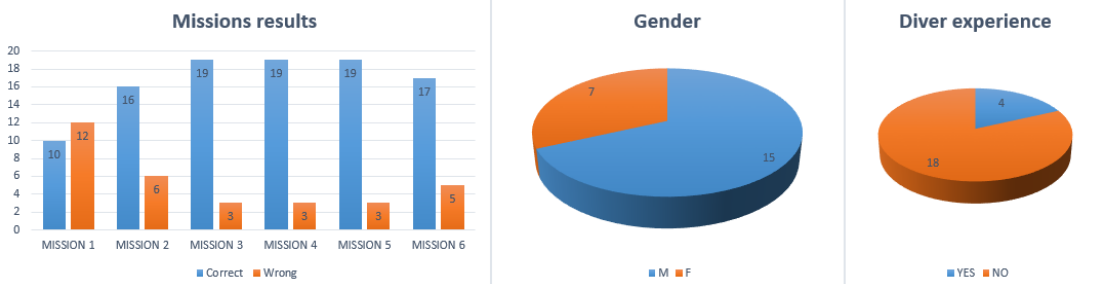
Figure 10. Evaluation of the six missions and description of volunteers data set.